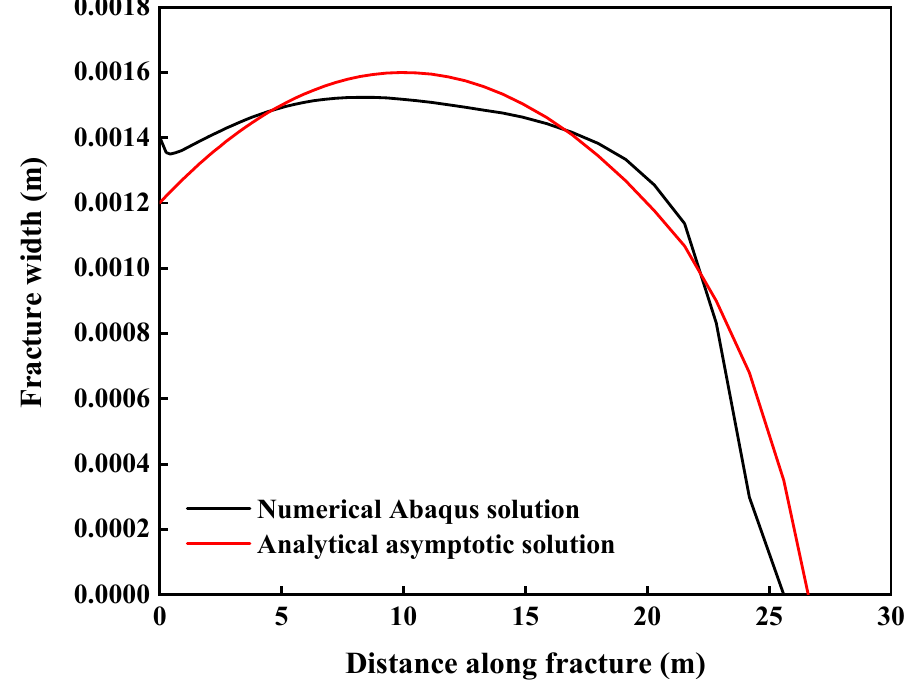
Figure 21. Fracture width distribution along fracture at the final time near the injection point (K vertex).